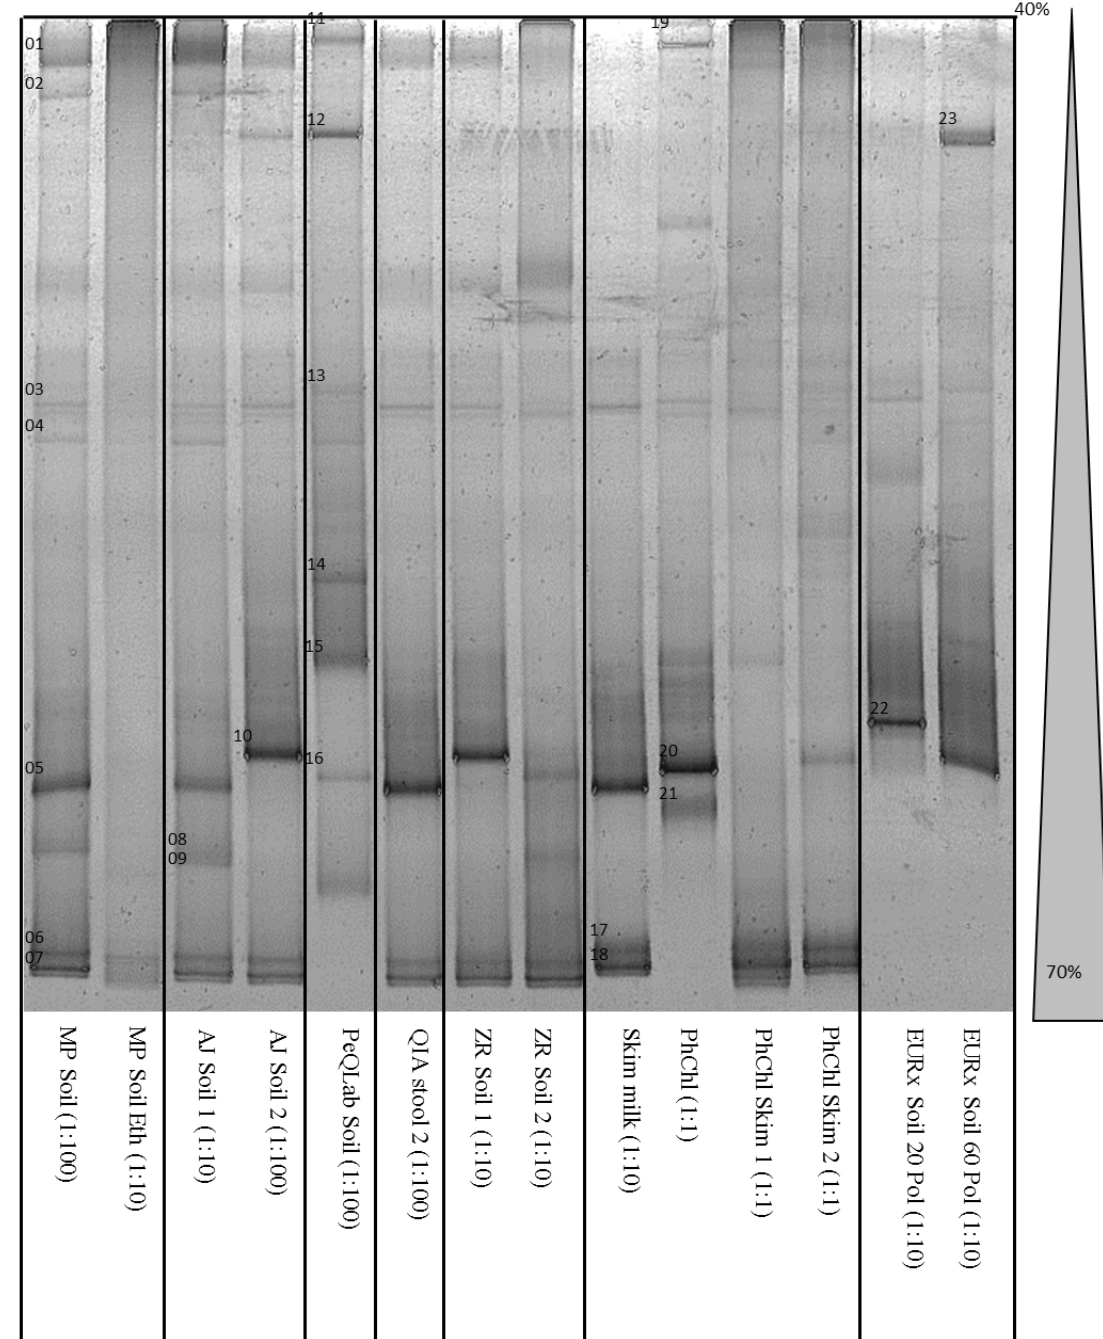
Figure 1. DGGE of 16S rDNA fragments obtained by several DNA extraction methods; DNA dilution for PCR in